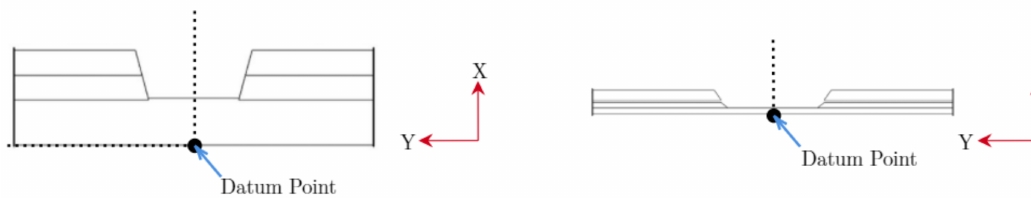
Figure 2. Schematic diagram illustrating the datum point of the wing geometry i.e., x Wi /c = 0, y Wi /c = 0 and z Wi /c =